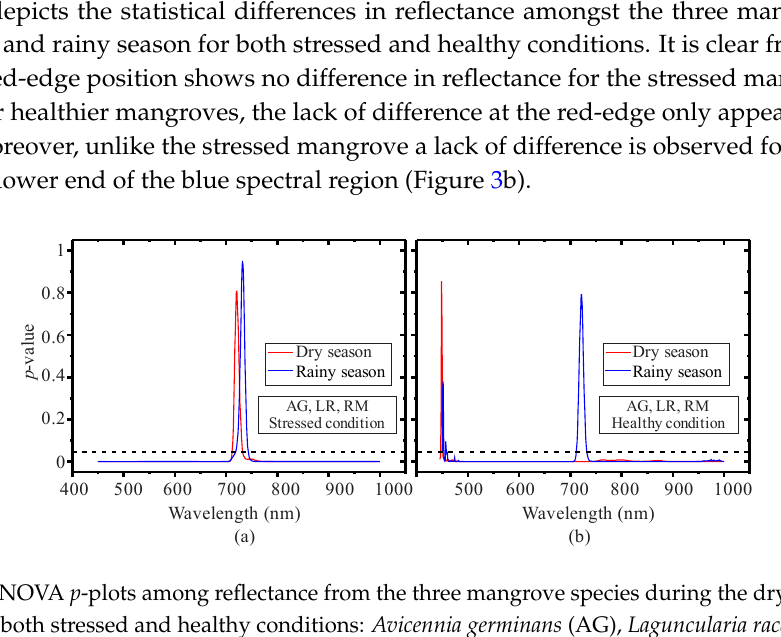
Figure 2. Spectral curves of the six mangrove classes during the dry and rainy seasons based on the means and the first standard deviations: Avicennia germinans (AG), Laguncularia racemosa (LR), and Rhizophora mangle (RM). The blue line represents the p -value between the dry and rainy season at each nanometer. p = 0.05 is shown by the flat dashed line across the bottom of each graph. ( a ) AG stressed condition; ( b ) AG healthy condition; ( c ) LR stressed condition; ( d ) LR healthy condition; ( e ) RM stressed condition; and ( f ) RM healthy condition.